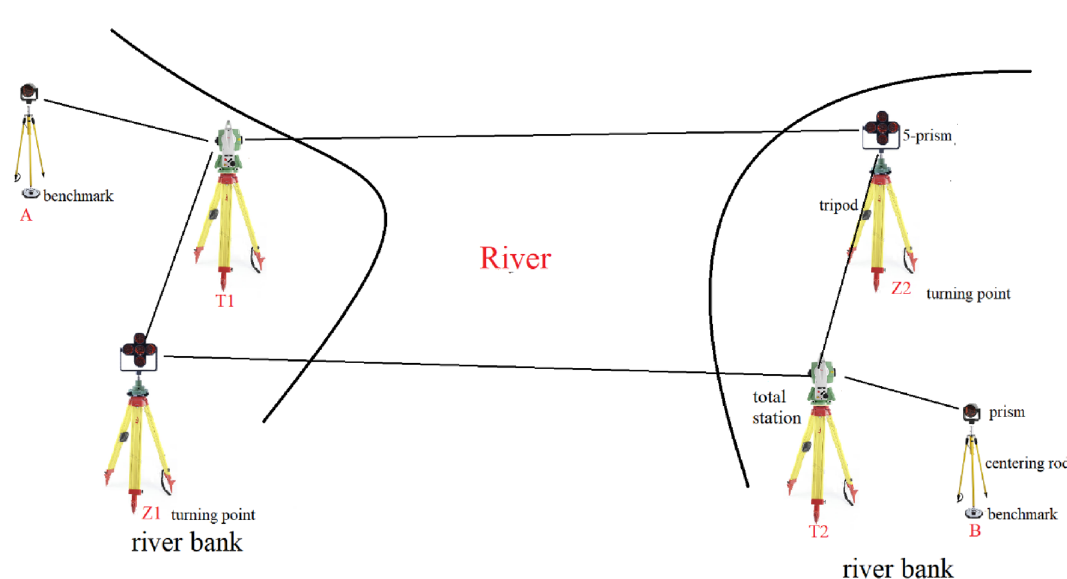
Figure 3. The surveying line of trigonometric levelling between two benchmarks on either side of the